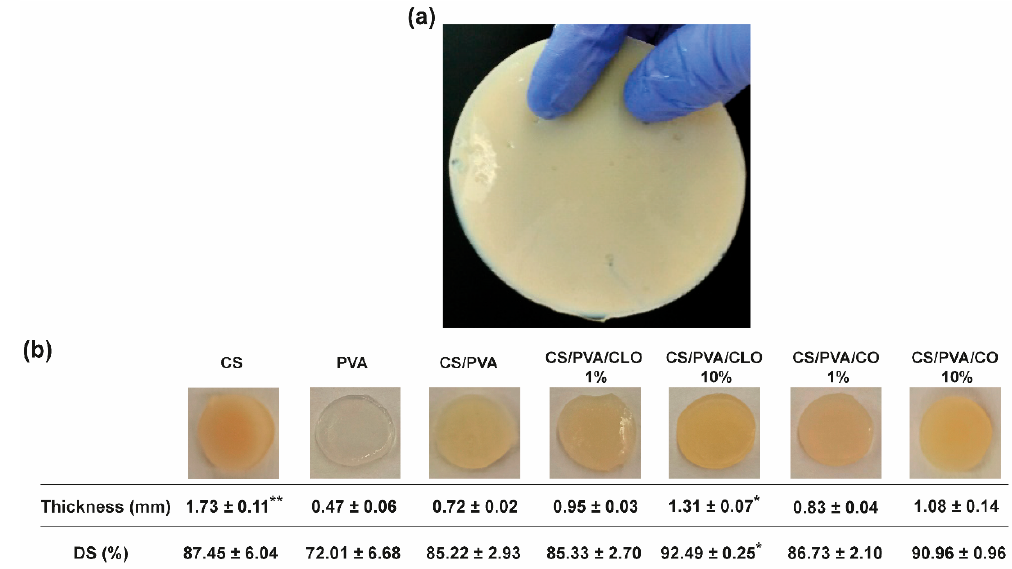
Figure 3. Macroscopic assessment of CS/PVA-based blended films. ( a ) Output created through the adapted solvent casting-phase inversion method, with overview hereby represented by the CS film, and ( b ) representative photographs of all built films, along with their corresponding measured thickness (mm), and gravimetrically-deduced DS (%). Results are shown as the mean ± SD ( n = 4 punched films with 11 mm of diameter each, cut from each film’s periphery to its center). * p < 0.05 and ** p < 0.001 in comparison to the CS/PVA film, using the Kruskal-Wallis test, followed by the Dunn’s multiple comparisons test.